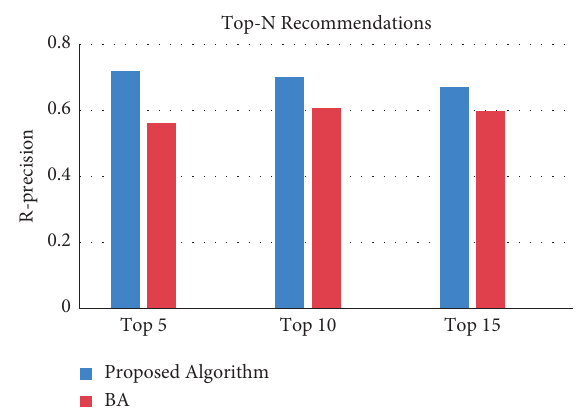
Figure 6: R -precision for the two recommender systems for dataset 2.